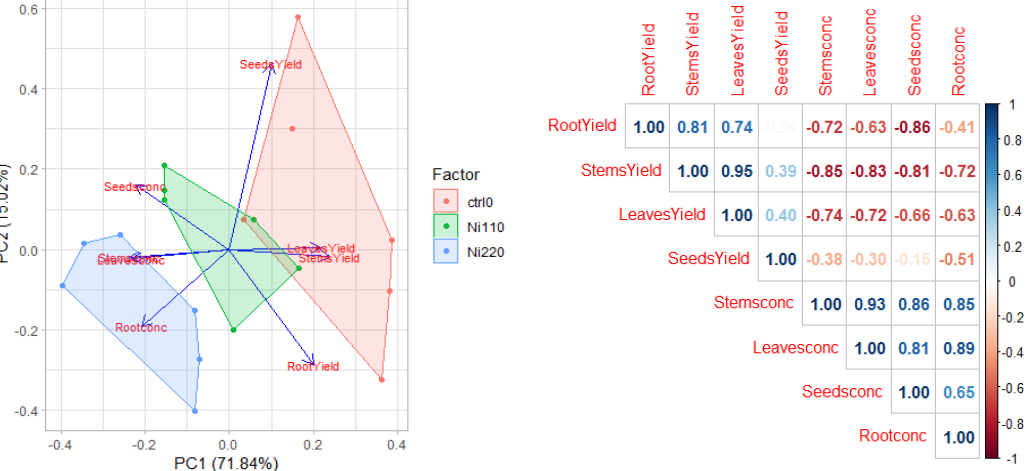
Figure 8. Principal component analysis and correlation matrix in nickel-contaminated soil in the two years.